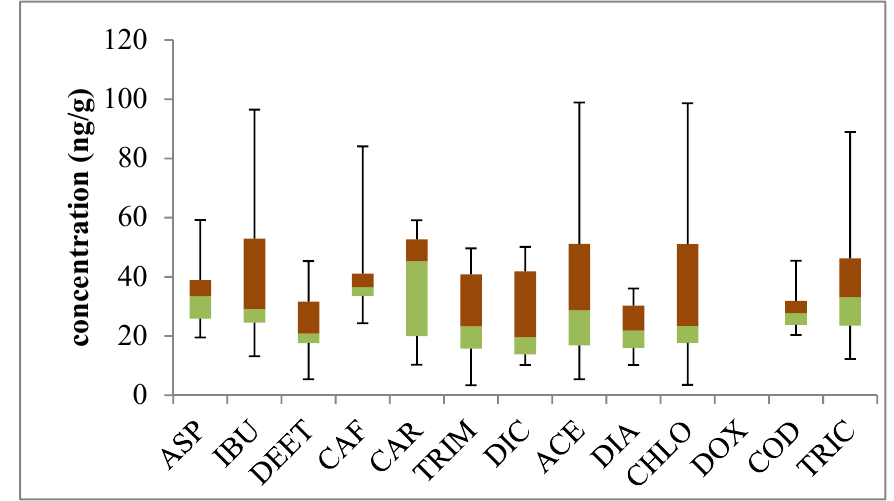
Figure 3. Box and whisker plot represents the mean concentration range (lowest, 25 percentile, median, 75 percentile and highest) of the PPCPs in the three sewage sludges.